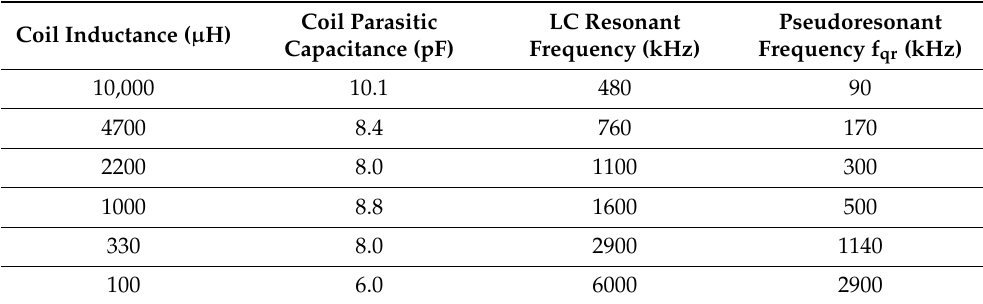
Table 1. Parameters of coils used in SPICE simulation, resonant frequency of free oscillation of resulting LC resonator and pseudo-resonant frequency of operation of PFVVS.